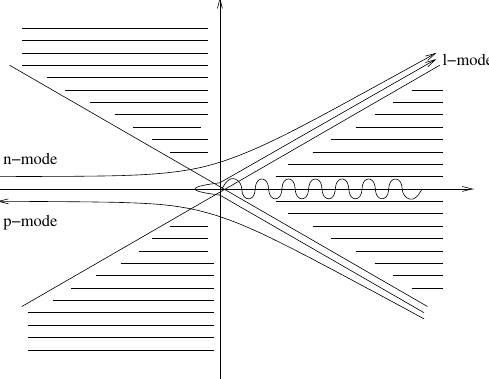
Figure 3. Paths for the Hawking partner in [13]. The dispersive modes involved are explicitly indicated, as well as the path near the cut at the branch point representing the Hawking partner ( l